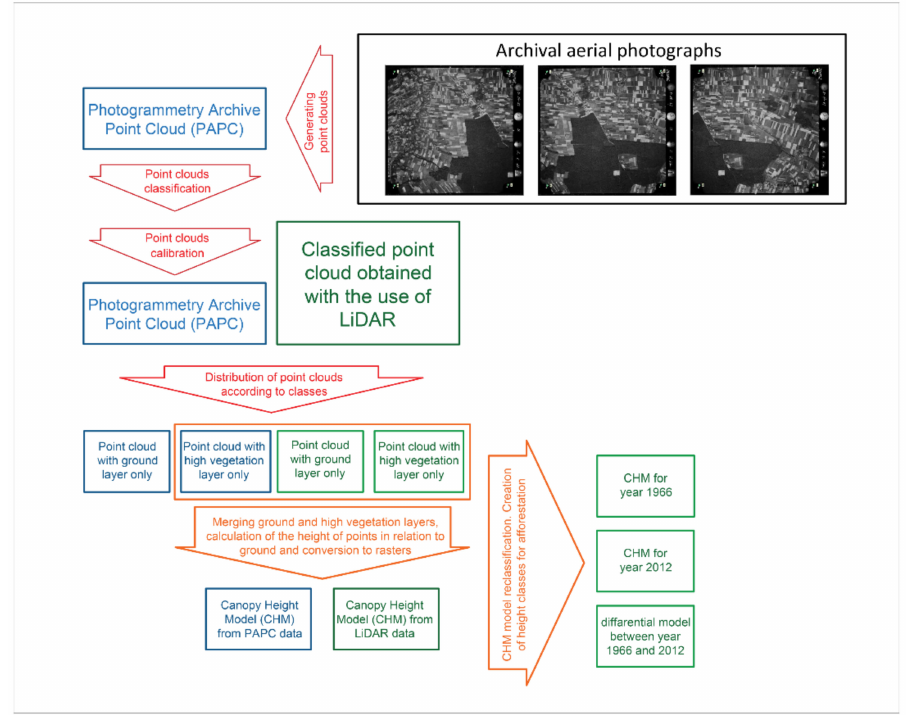
Figure 3. Scheme presenting the methodology used in the processing of archival aerial